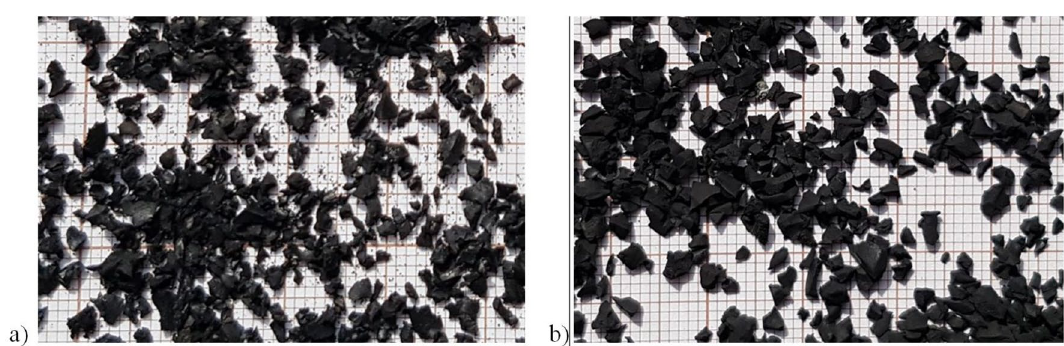
Figure 3. Samples taken from sport fields: ( a ) SBR granules, ( b ) EPDM